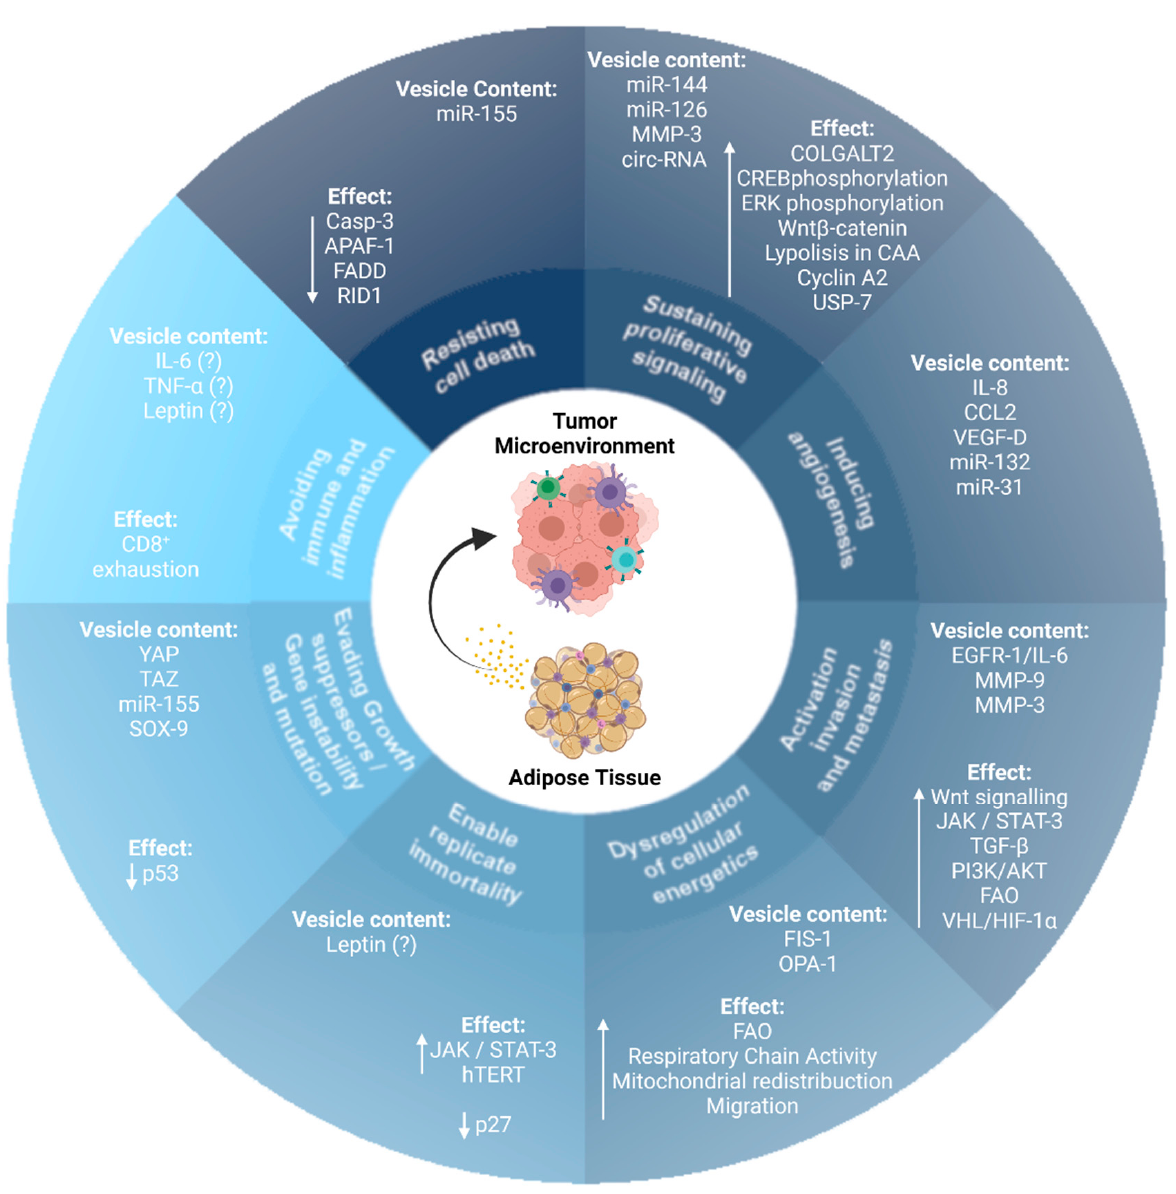
Figure 1. Extracellular vesicles (EVs) derived from adipose tissues modulate the acquisition and maintenance of cancer hallmark traits. EVs derived from adipose tissue modulate the acquisition and maintenance of the hallmark traits of cancer. MicroRNA (miR); circulating-RNA (circ-RNA); procollagen galactosyltransferase 2 (COLGALT2); cAMP response element-binding protein (CREB); CAA (cancer-associated adipocytes); ubiquitin-specific-processing protease 7 (USP-7); interleukin-8 (IL-8), C-C motif chemokine ligand 2 (CCL2), and vascular endothelial growth factor-D (VEGF-D); epidermal growth factor receptor 1 (EGFR1); interleukin 6 (IL-6); metalloproteinase 3 (MMP-3); metalloproteinase 9 (MMP-9); transforming growth factor β (TGF- β ); janus kinase (JAK); signal transducer and activator of transcription 3 (STAT-3); hypoxia-inducible factor-1 α (HIF1- α ); von-Hippel Lindau tumor suppressor (VHL); mitochondrial fission protein 1 (FIS-1); mitochondrial dynamin-like GTPase (OPA-1); fatty acid oxidation (FAO); human telomerase reverse transcriptase (hTERT); yes-associated protein 1 (YAP); taffazin (TAZ); caspase 3 (Casp-3); apoptotic peptidase activator factor 1 (APAF-1); Fas-associated death domain protein (FADD); GTPase-binding protein rid1 (RID1); SRY-box transcription factor 9